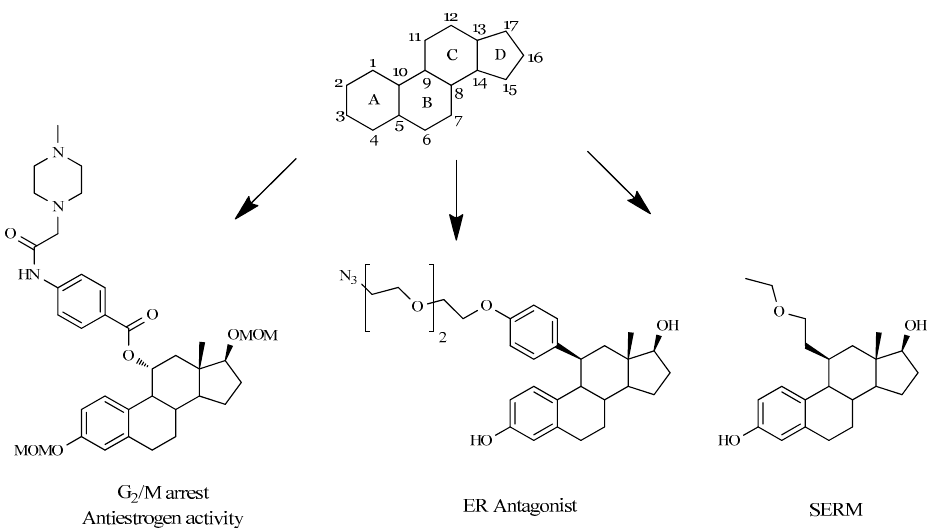
Figure 1. Some examples of C-ring modifications in estrane series with biological activities [5,17,18]. ER, estrogen receptor; SERM selective estrogen receptor modulator.